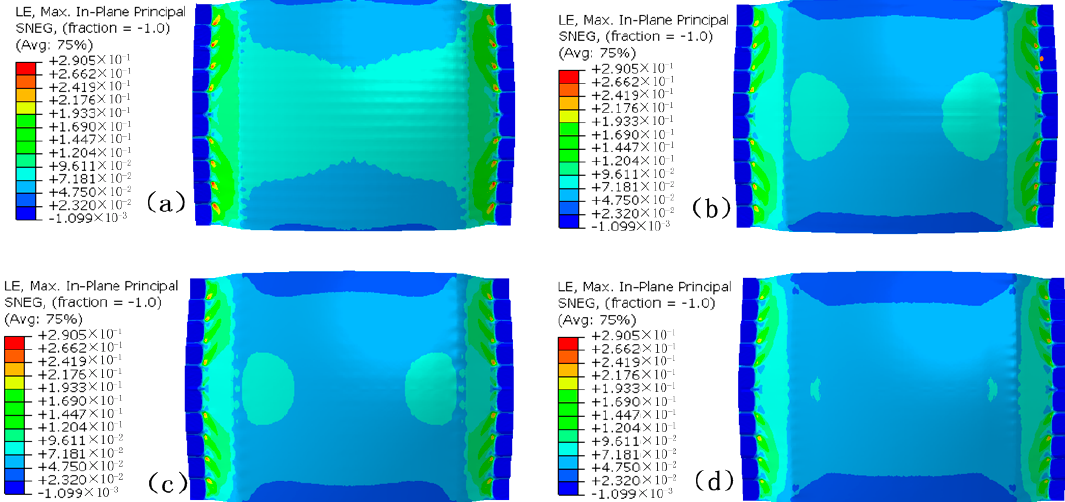
Figure 9. Tension strain distribution of the formed parts: ( a ) formed by FBHC, ( b ) formed by SBHC, ( c ) formed by SBHDS and ( d ) formed by SBHPS.